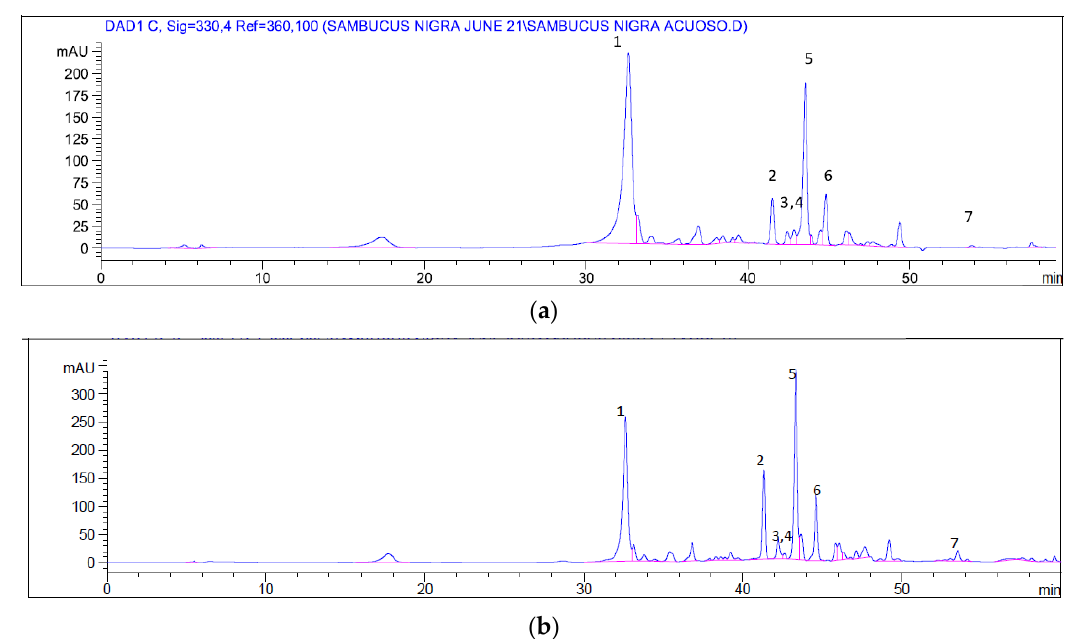
Figure 1. Representative chromatographic profile of ( a ) aqueous and ( b ) ethanolic extracts from S. nigra flowers, under the described analytical conditions measured at 330 nm. See identification of peaks in Table 2.